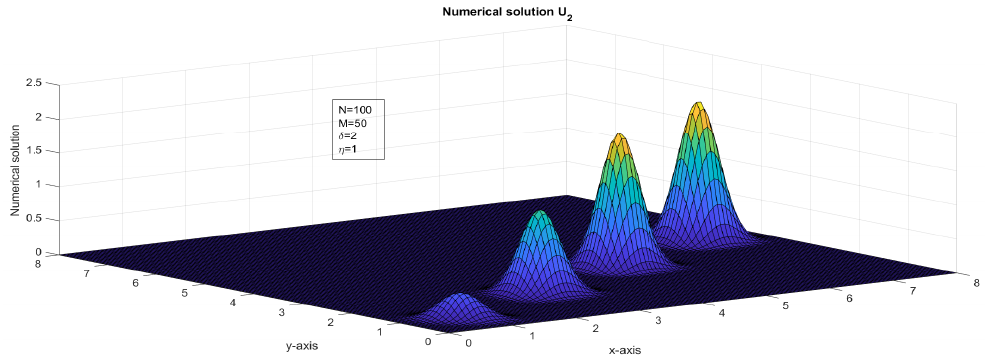
Figure 13. The surface plot illustrates the numerical solution, U 1 , for Case 2 in Example 1.